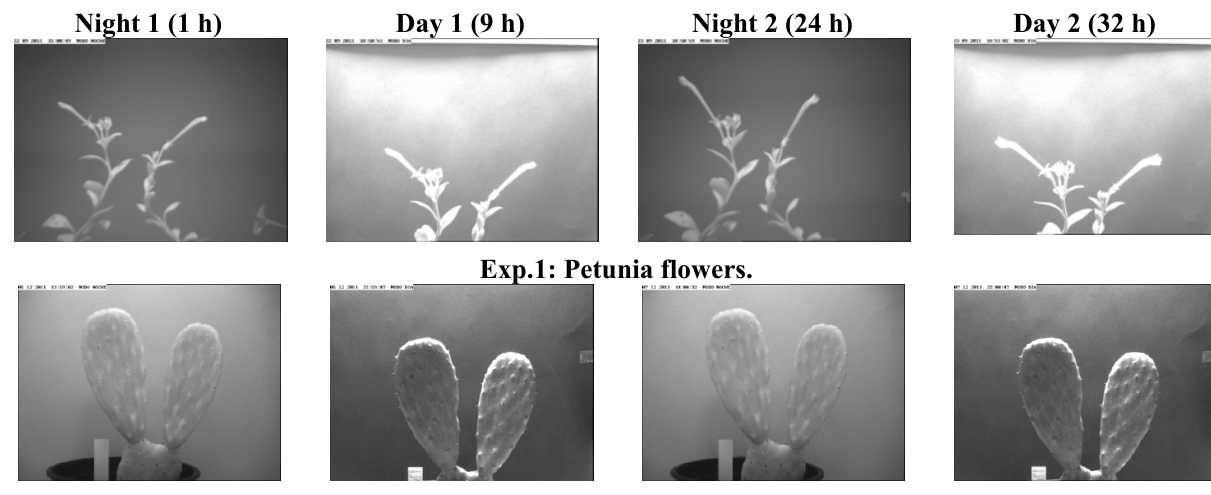
Figure 4. Images taken during two experiments under different illumination